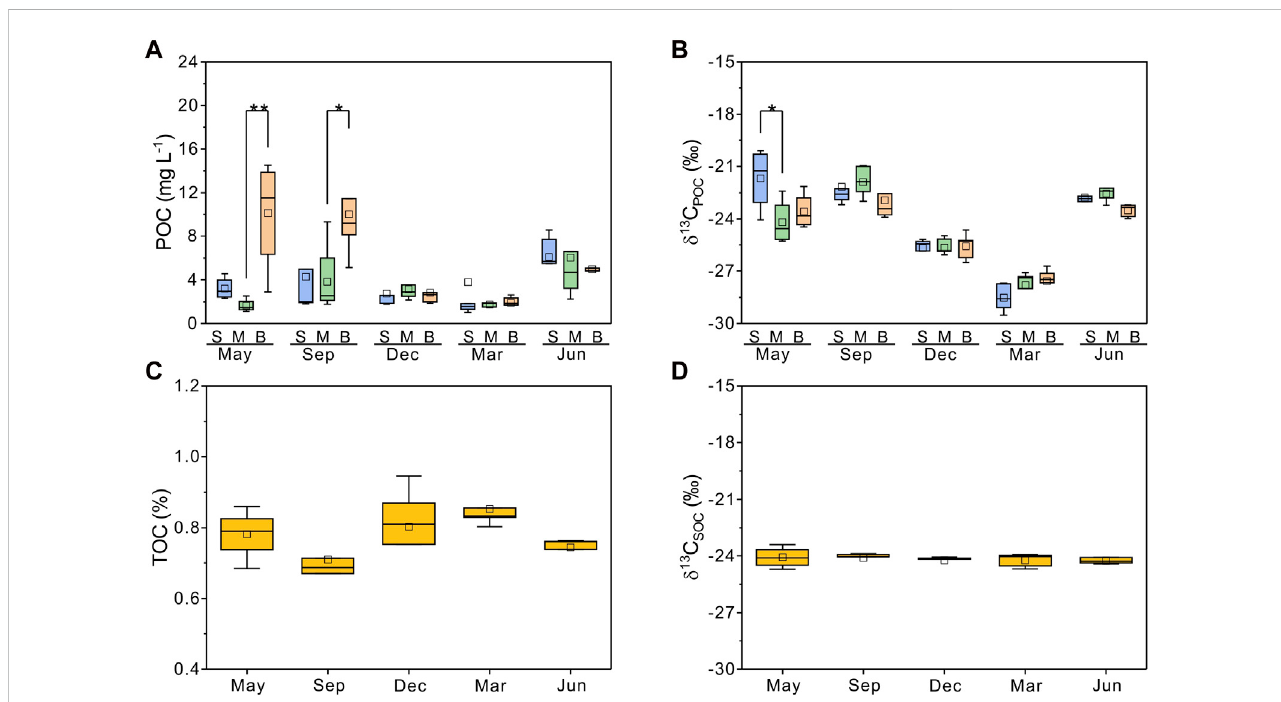
FIGURE 3 Concentrations and stable carbon isotopic compositions of particulate organic carbon (POC, δ 13 C POC , n = 77) and sedimentary organic carbon (TOC, δ 13 C n = 24). (A,B) are POC and δ 13 C SOC , POC along the water column across seasons, respectively. (C,D) are TOC and showaverage(hollow point),median(line), fi rst andthirdquartiles (hinges),and 1IQR(whiskers). Thesigni fi cantdifference between POCand δ 13 C POC istested between surface water (S), middle water (M), and bottom water (B). The level of signi fi cance from the one-way analysis is reported as * p < 0.05 and ** p <